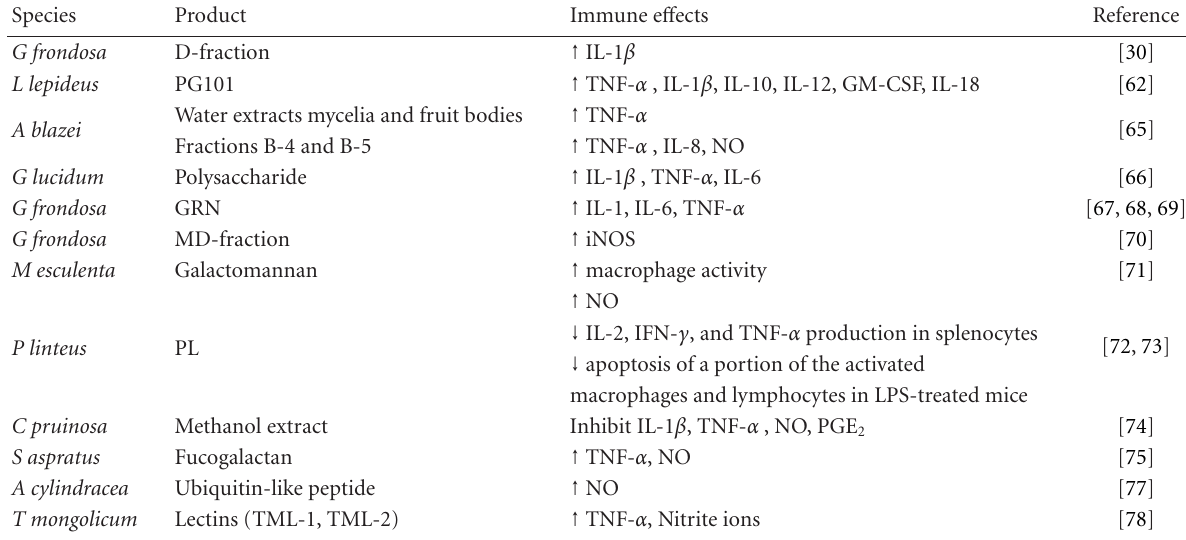
Table 2. Immunomodulatory activities of mushroom products on